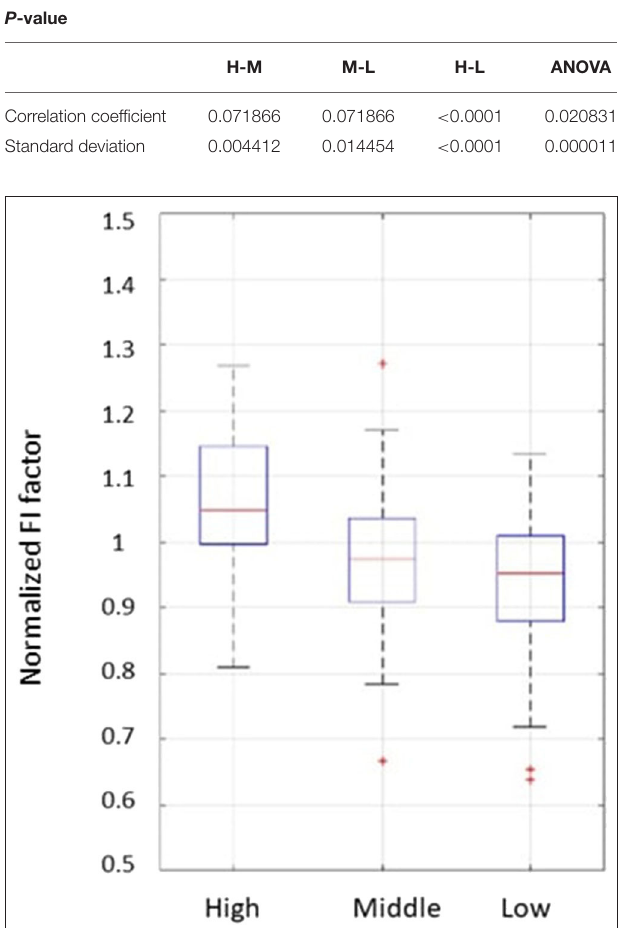
TABLE 2 | P -value of different comparison pairs.